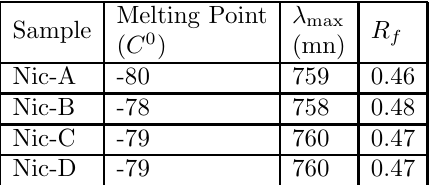
Table 2. Characteristics of purified Nicotine isolated from